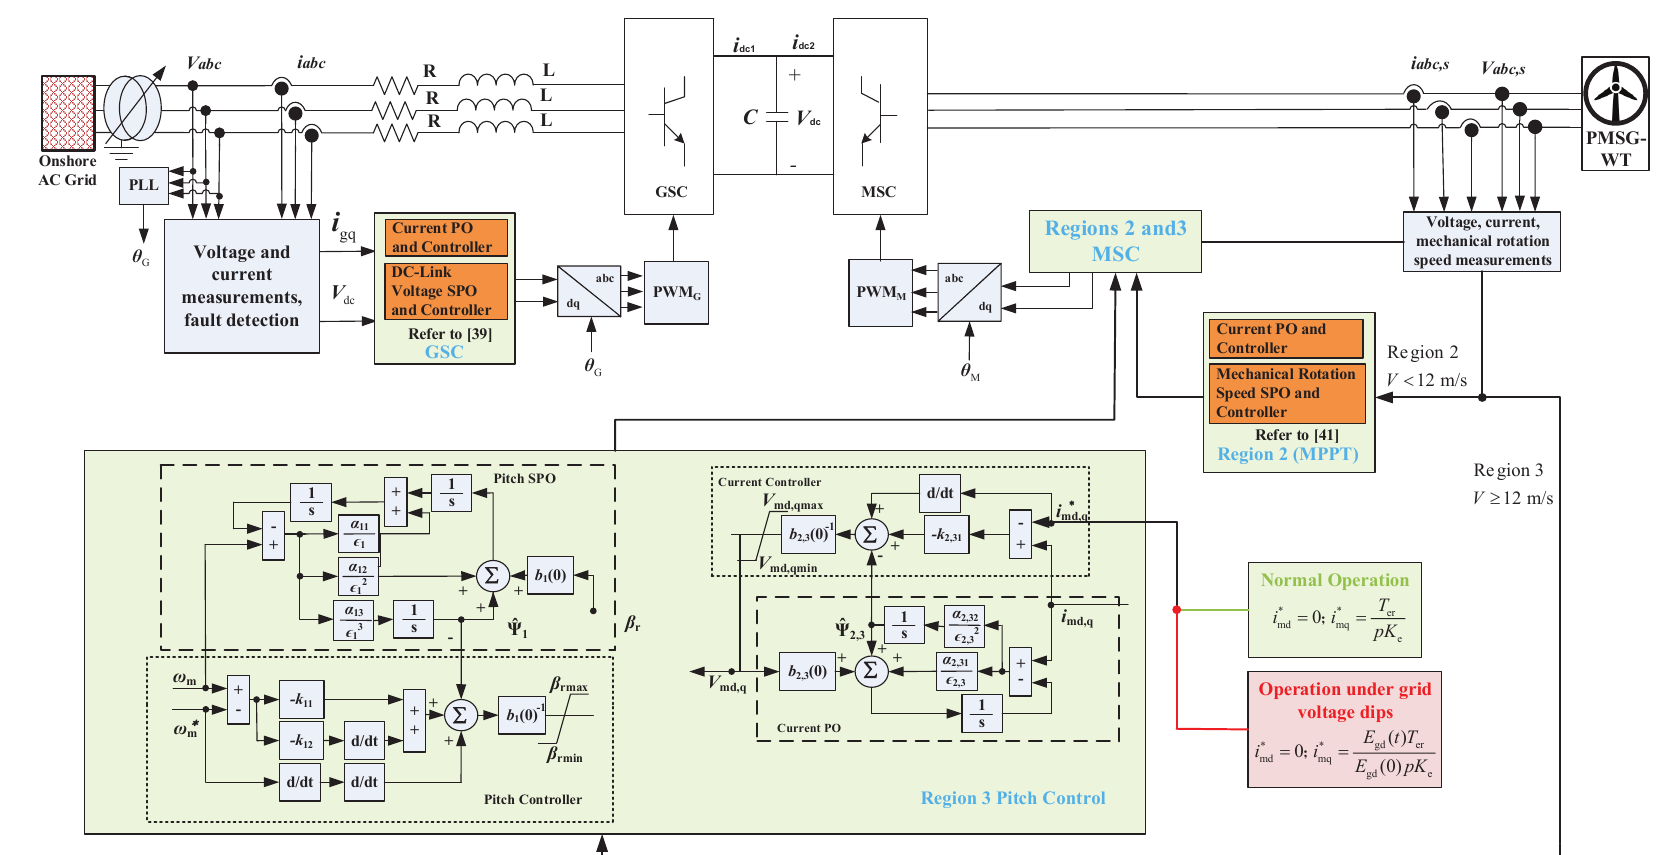
Figure 3. The overall control structure of the adaptive control-based GSC and MSC for the WECS based on